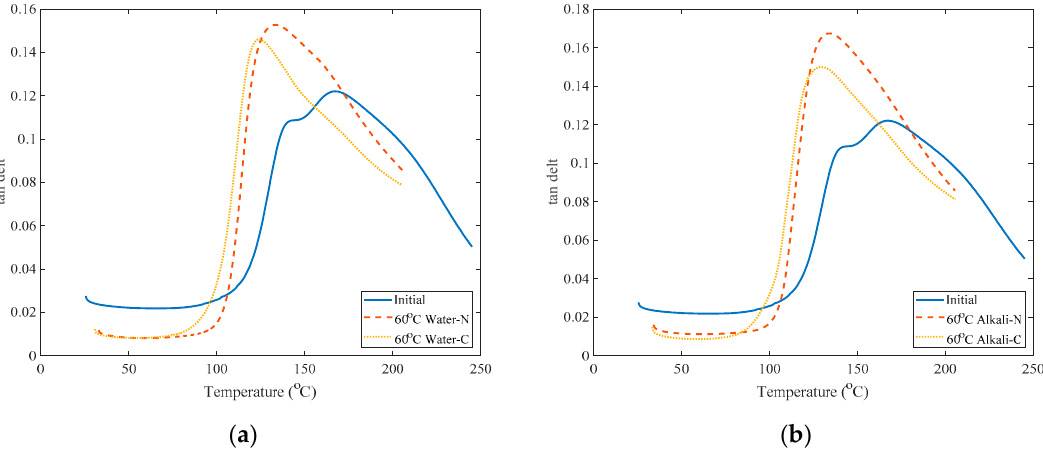
Figure 11. Comparison of tan δ between initial specimens and those immersed for three months. Table 3. Tan δ variation of specimens immersed for three months.